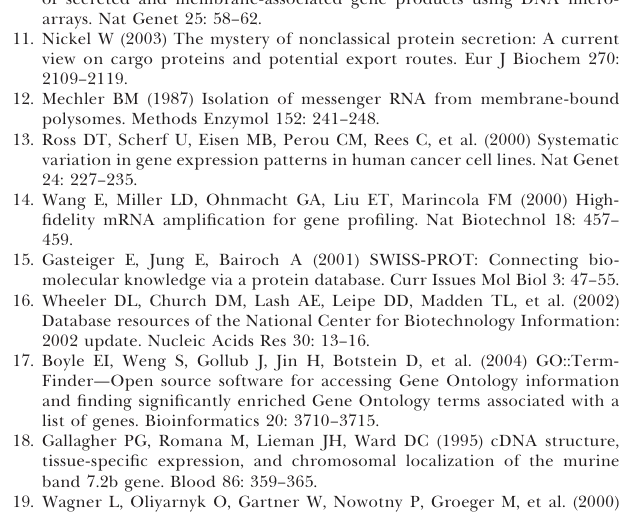
Figure S1. Relationship of Tumors and Normal Tissues Based on the Expression of MS Protein Encoding Genes In order to examine the relationship between tumor and normal specimens stemming from the same tissue, mean centroids were calculated for each tumor and normal tissue group. These were then hierarchically clustered using average linkage clustering. Tumor and